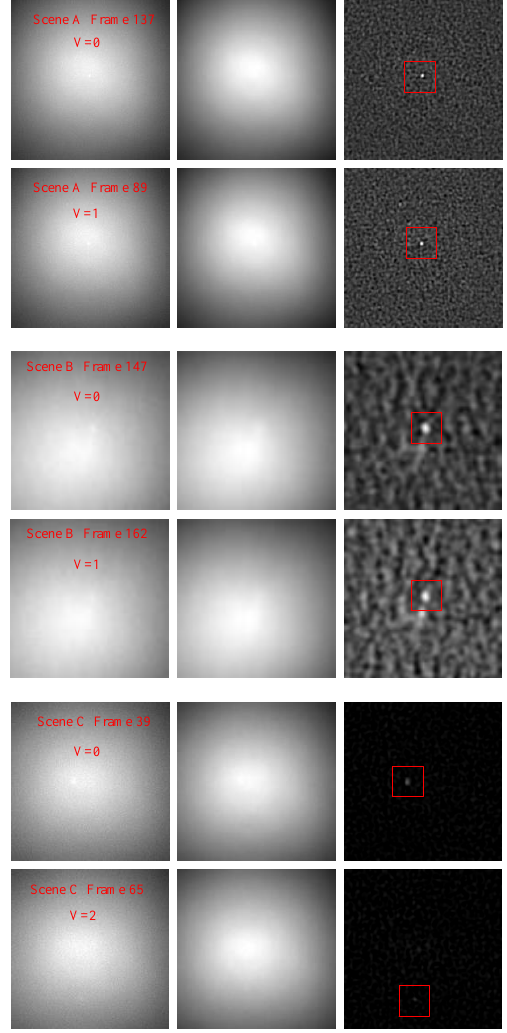
Figure 9. The background suppression effect of SPB when the target velocity is minimum and maximum of scenes A, B, and C.